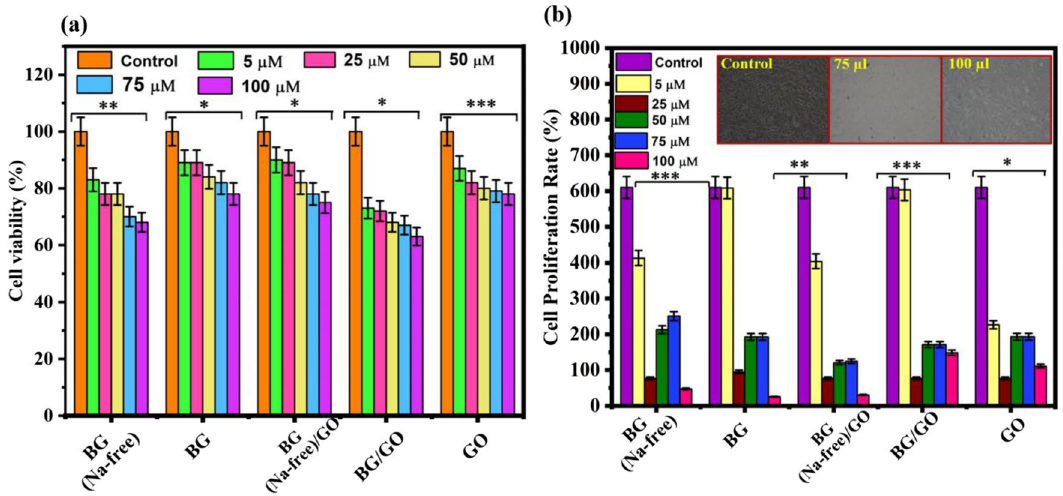
Figure 8. Cytocompatibility and cell proliferation properties; ( a ) cell viability of BG, BG (Na-free), GO and BG/ GO, BG (Na-free)/GO nanocomposites over L929 for the incubation for 24 h. The asterisks indicate significant difference (*p < 0.02, **p < 0.08, ***p < 0.02), ( b ) cell proliferation of fibroblast cells on BG, BG (Na-free), GO and BG/GO, BG (Na-free)/GO nanocomposites for 72 h incubation. The asterisks indicate significant difference